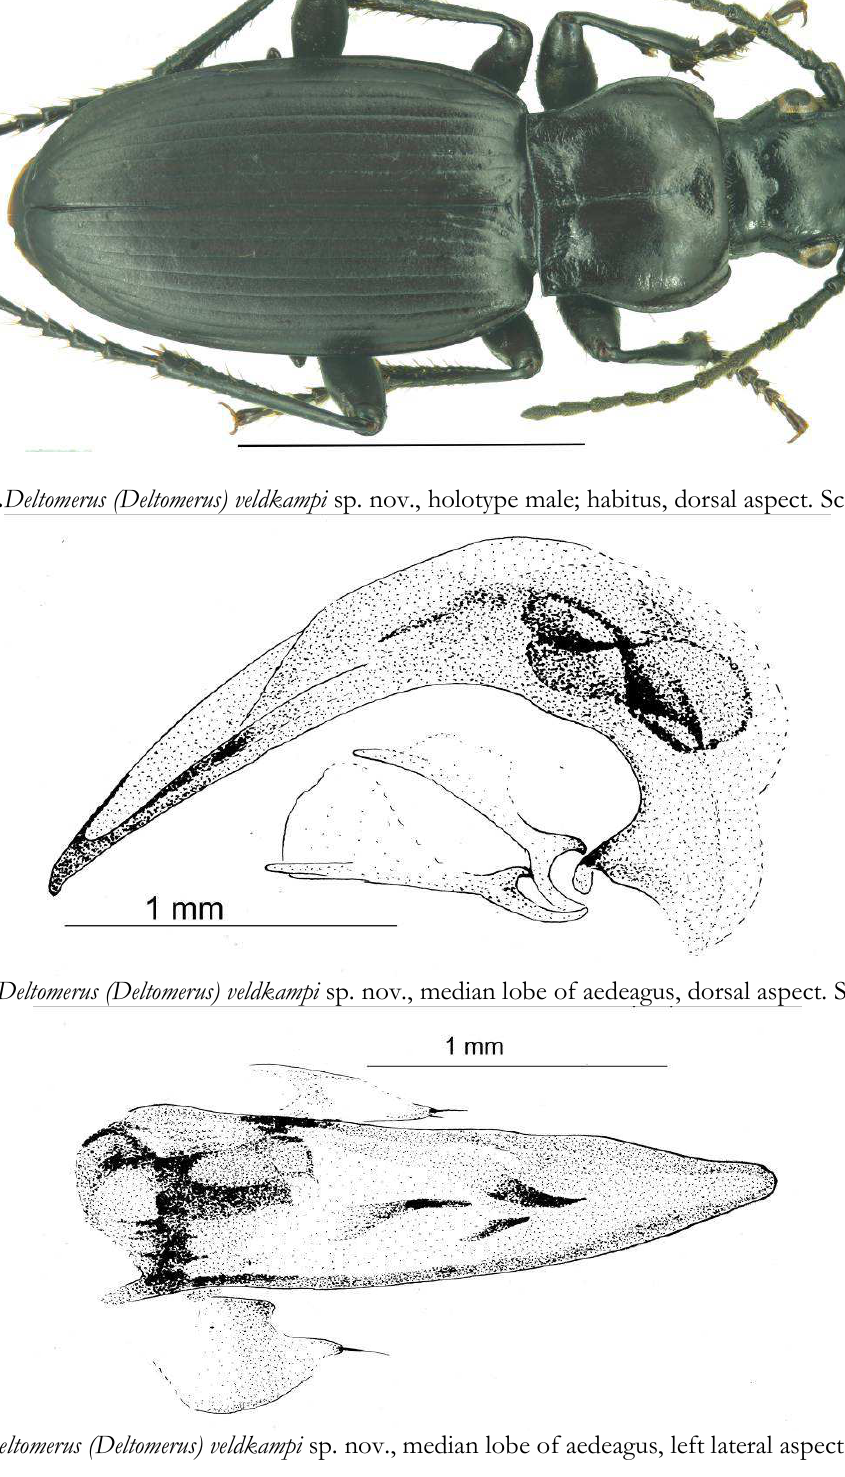
F IGURE 5. Deltomerus (Deltomerus) veldkampi sp. nov., median lobe of aedeagus, left lateral aspect. Scale: